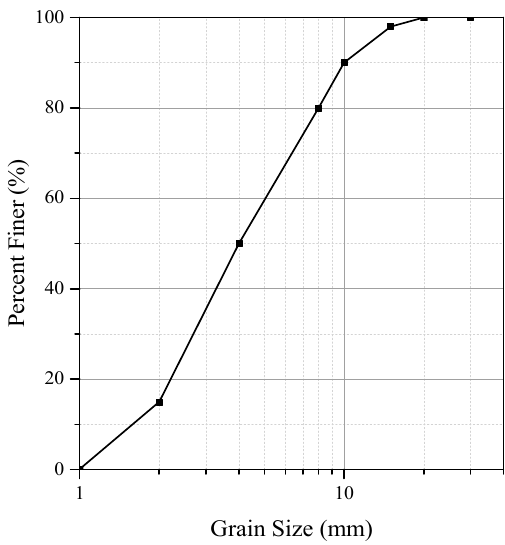
Table 1. Hydraulic condition for each set of laboratory flume experiments.